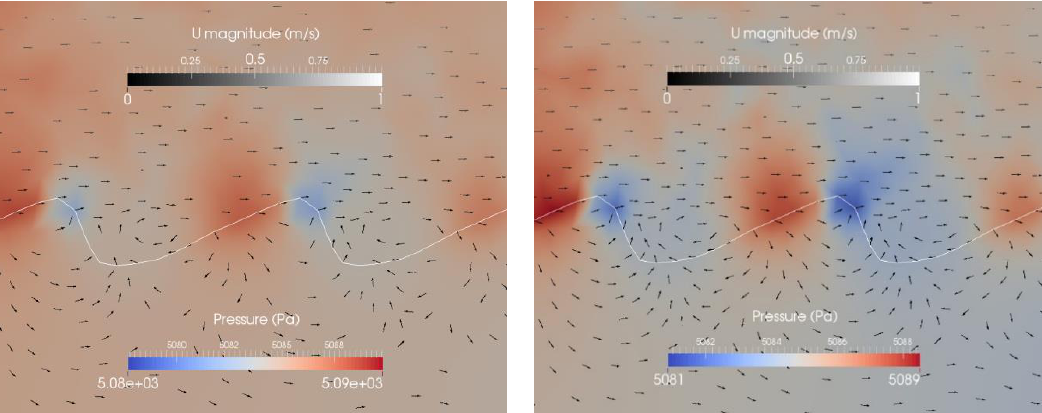
Figure 8. Pressure distribution and velocity vectors at a sandy (left) and gravel (right) ripple for case 2 (Table 1). The white line indicates the sediment-water interface. The colors indicate the pressure distribution. Please note that the scaling is different in the right and the left panel. The arrows indicate flow directions of the surface and the subsurface flow. To visualize the intensity of the flow U a grey is used.